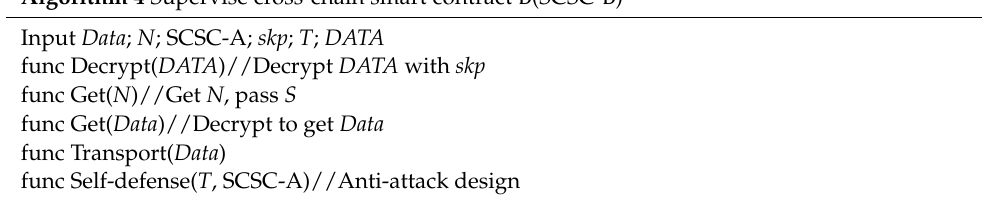
Algorithm 4 Supervise cross-chain smart contract B(SCSC-B)